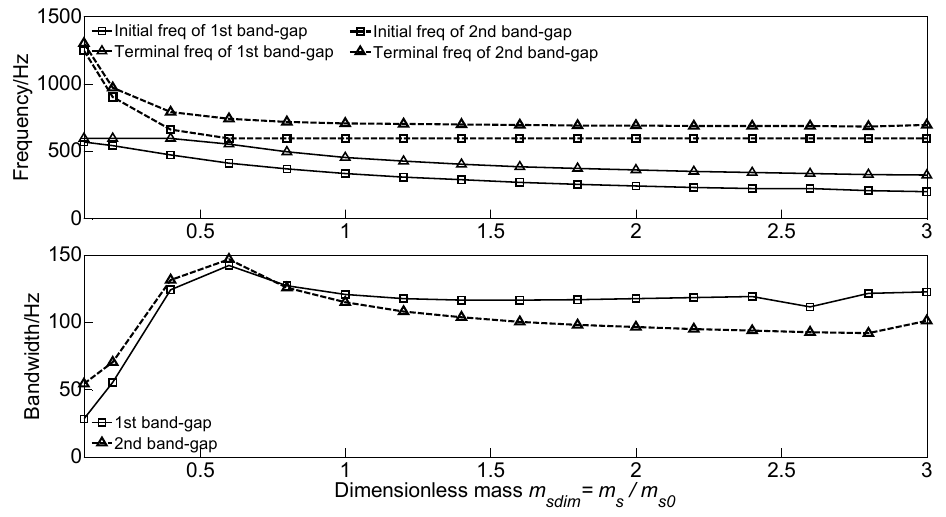
Figure 6. Band gaps maps as functions of dimensionless mass m sdim.